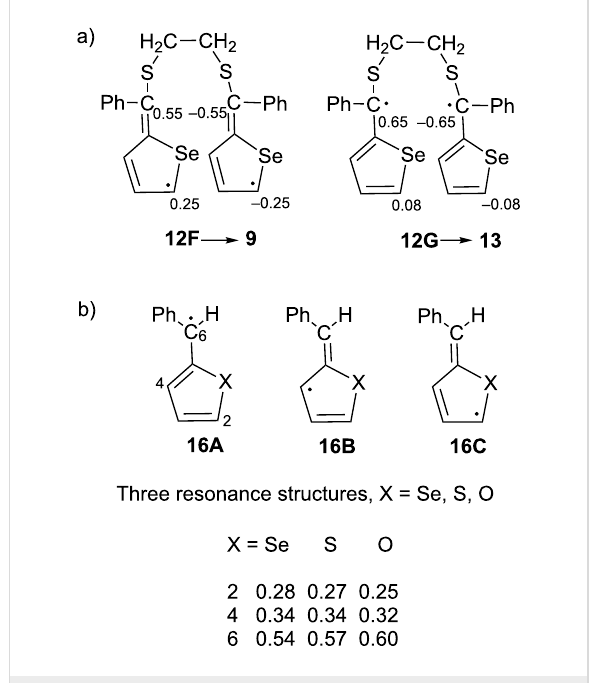
Figure 5: a) Spin densities in the conformers 12F and 12G of diradical 12 . b) Heteroatom effect on the magnitude of the spin density in the model diradical 16